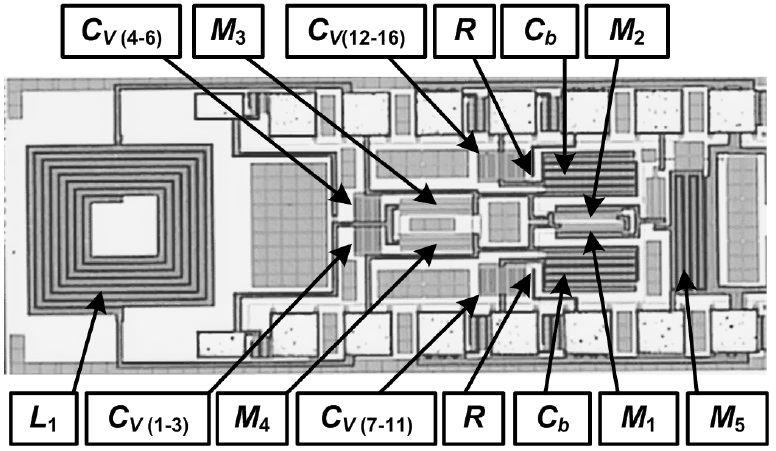
Figure 13. Photomicrograph of the fabricated 433 MHz direct-modulation transmitter.